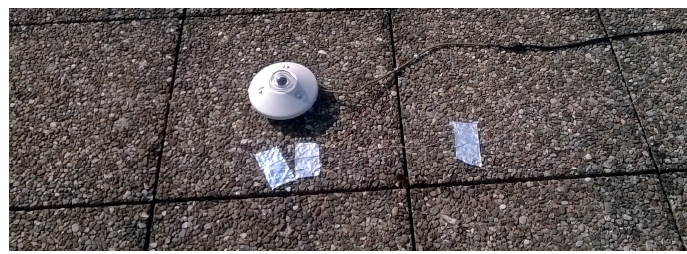
Figure 4. Surface temperature sensor installed on the flat roof (T sfloor ) and solarimeter.